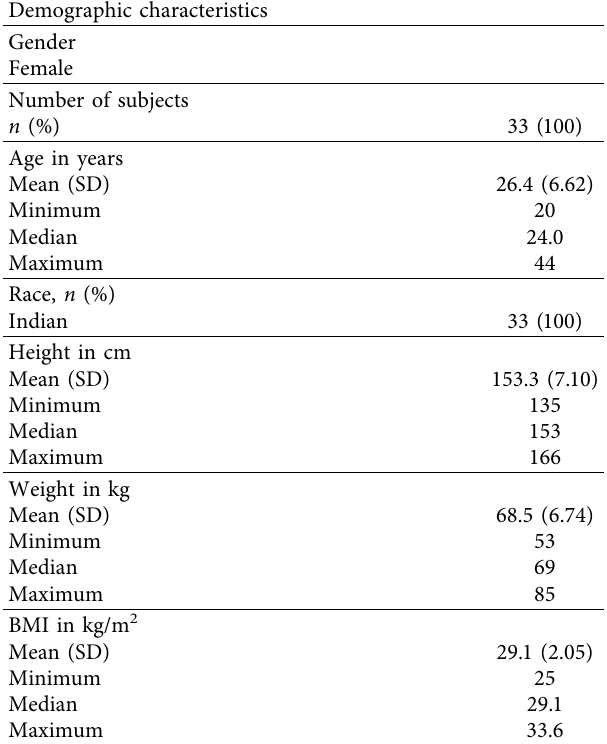
Table 1: Patient demographics collected on enrollment. Demographic characteristics